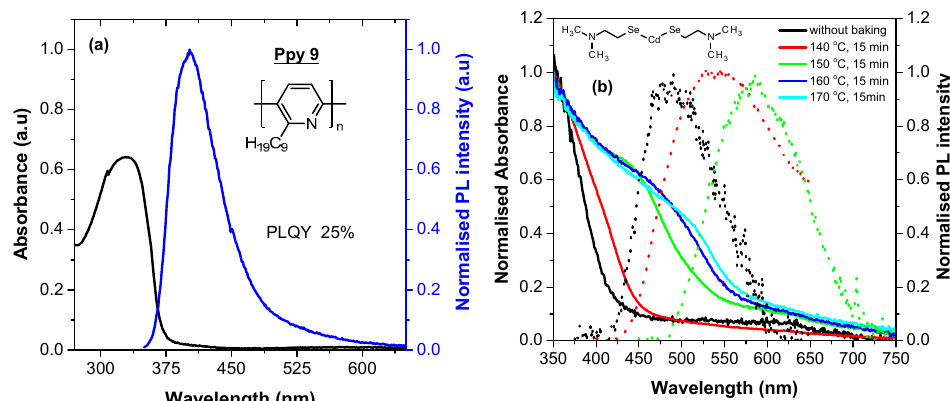
Figure 1. Absorption and fluorescence spectra of neat films. ( a ) poly(6-nonylpyridine-2,5-diyl) (Ppy9); ( b ) CdDMASe precursor before annealing and after annealing at different temperatures for 15 min. The molecular structures of materials are given in the inset.